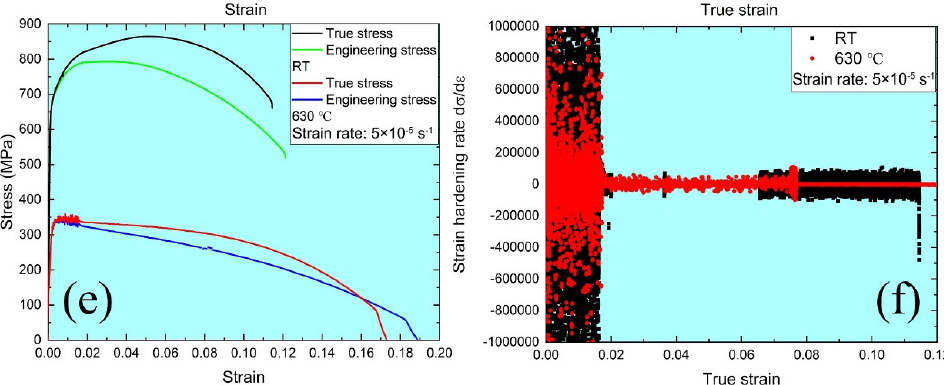
Figure 4. Stress–strain curves and strain hardening rate of tensile samples at RT and 630 ◦ C: Figure 4. Stress ‐ strain curves and strain hardening rate of tensile samples at RT and 630 °C: ( a , b ) 5 ( a , b ) 5 × 10 − 3 s − 1 ; ( c , d ) 5 × 10 − 4 s − 1 ; ( e , f ) 5 × 10 − 5 s − 1 Table 3. Detailed tensile behavior under different strain rates at RT and 630 °C.